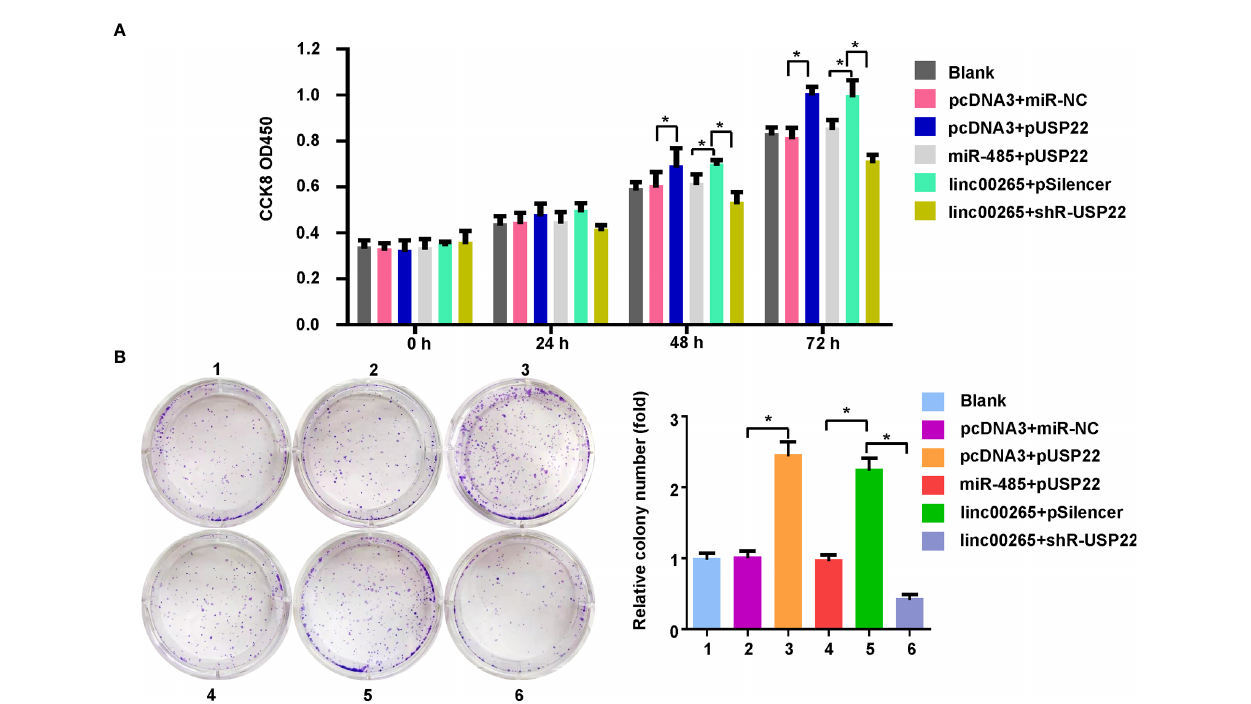
FIGURE 6 | Linc00265 promoted cell viability and colony formation via miR-485-5p/USP22 axis. (A) Cell viability was examined by CCK-8 assay in osteosarcoma cells after linc00265 modi fi cation, miR-485-5p changes, or USP22 modi fi cation or combination. (B) The colony formation ability was measured in osteosarcoma cells after linc00265 modi fi cation, miR-485-5p changes, or USP22 modi fi cation or combination. The quantitative data were demonstrated for colony formation (Right panel). 1: Blank. 2: pcDNA3 + miR-NC. 3: pcDNA3 + pUSP22. 4: miR-485 + pUSP22. 5. Linc00265 + pSilencer. 6. Linc00265 + shR-USP22. * P < 0.05 vs.